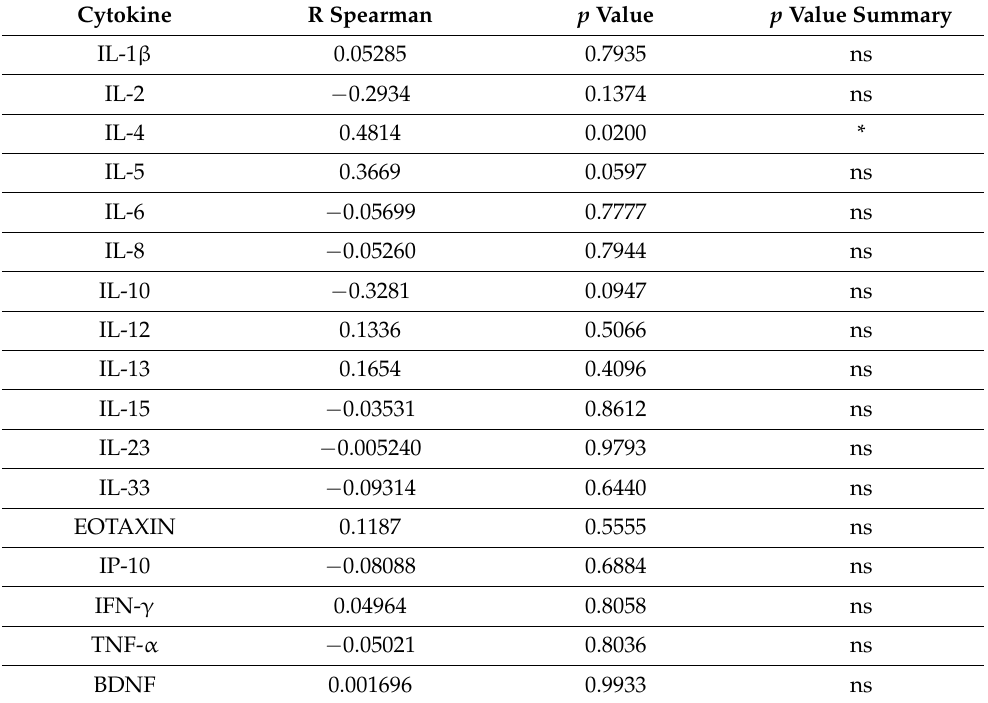
Table 4. Correlation table between cytokines and chemokines with the Expanded Disability Status Scale.